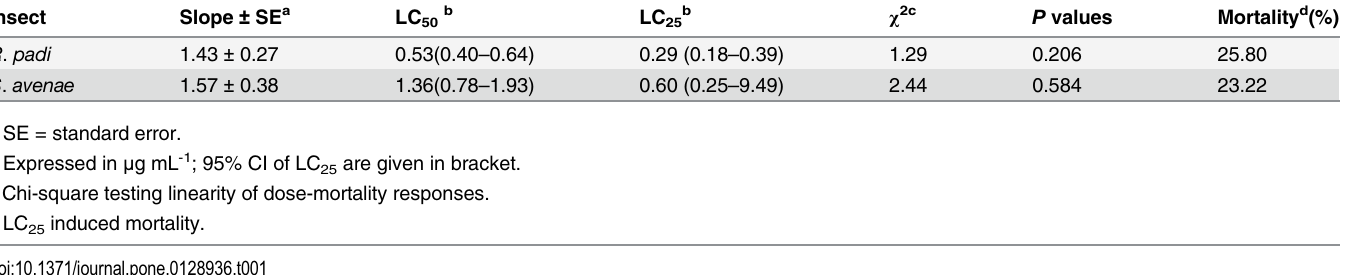
Table 1. LC 25 values and mortality for pirimicarb toxicity on R . padi and S . avenae after 3 h exposure to treated glass tubes. Insect